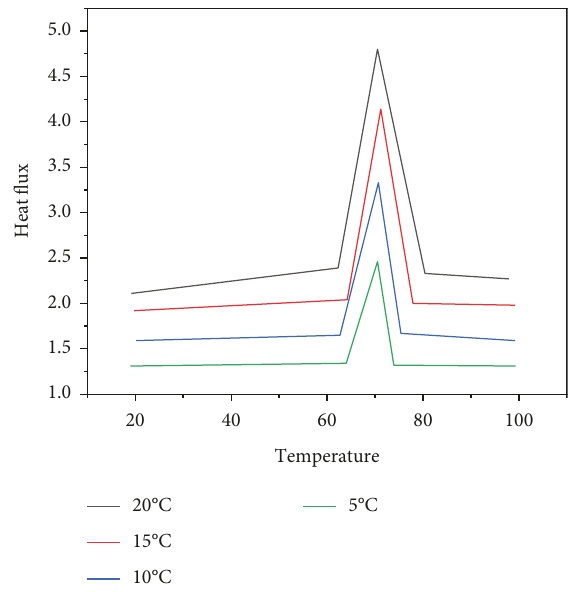
Figure 5: DSC curves of SA/A-CNT at different heating rates.